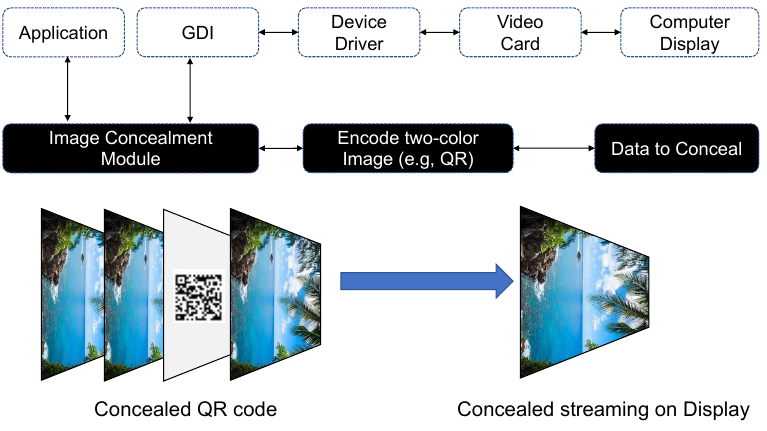
Figure 9. Air-gap attack concept using monitor screen